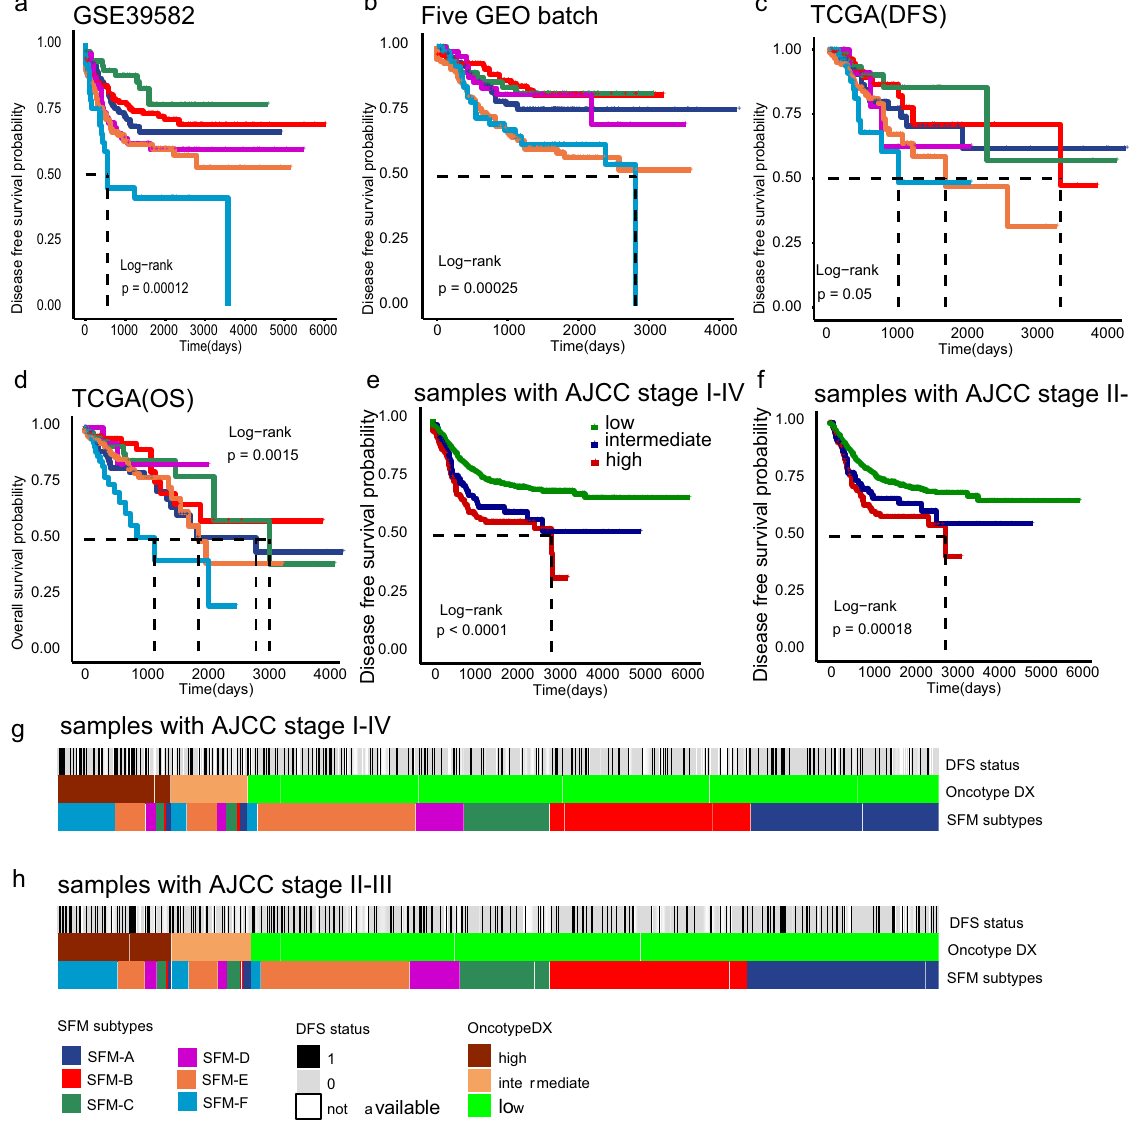
Fig. 4 Survival differences across SFM subtypes. Kaplan – Meier plots of DFS and OS in training dataset ( a , GSE39582) and validation dataset ( b , fi ve GEO batch; c , TCGA for DFS; and d , TCGA for OS). e Kaplan – Meier plots of Oncotype DX risk groups in stage I – IV cases. f Kaplan – Meier plots of Oncotype DX risk groups in stage II – III cases. The tick marks on the Kaplan – Meier curves indicated the censored patients. The differences between the curves were determined by the log-rank test. g Comparison of SFM subtypes and Oncotype DX classi fi cation in stage I – IV cases. h Comparison of SFM subtypes and Oncotype DX classi fi cation in stage II and III